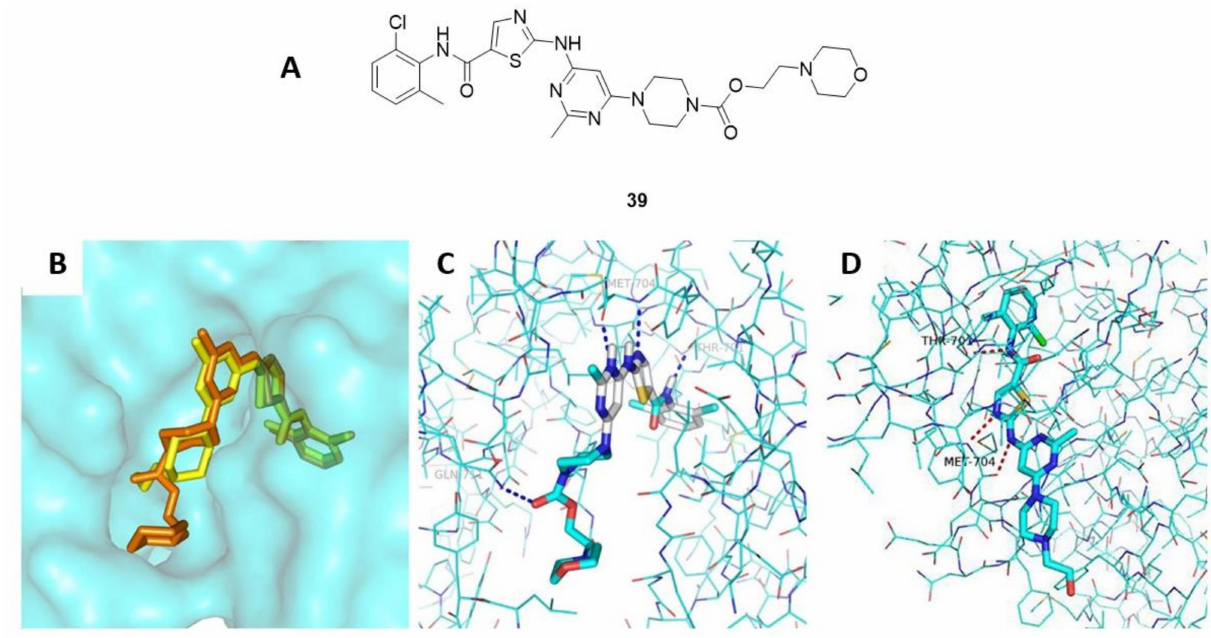
Figure 16. ( A ) Chemical structure of compound 39 ; ( B ) Both compounds 39 (orange) and dasatinib ( 1 ) (yellow) overlayed in the active site residue of DDR1 kinase (PDB ID: 5BVW); ( C ) docking of compound 39 within DDR1 active site ( D ) Docking of dasatinib (1) within DDR1 active site. Reprinted with permission from Ref.